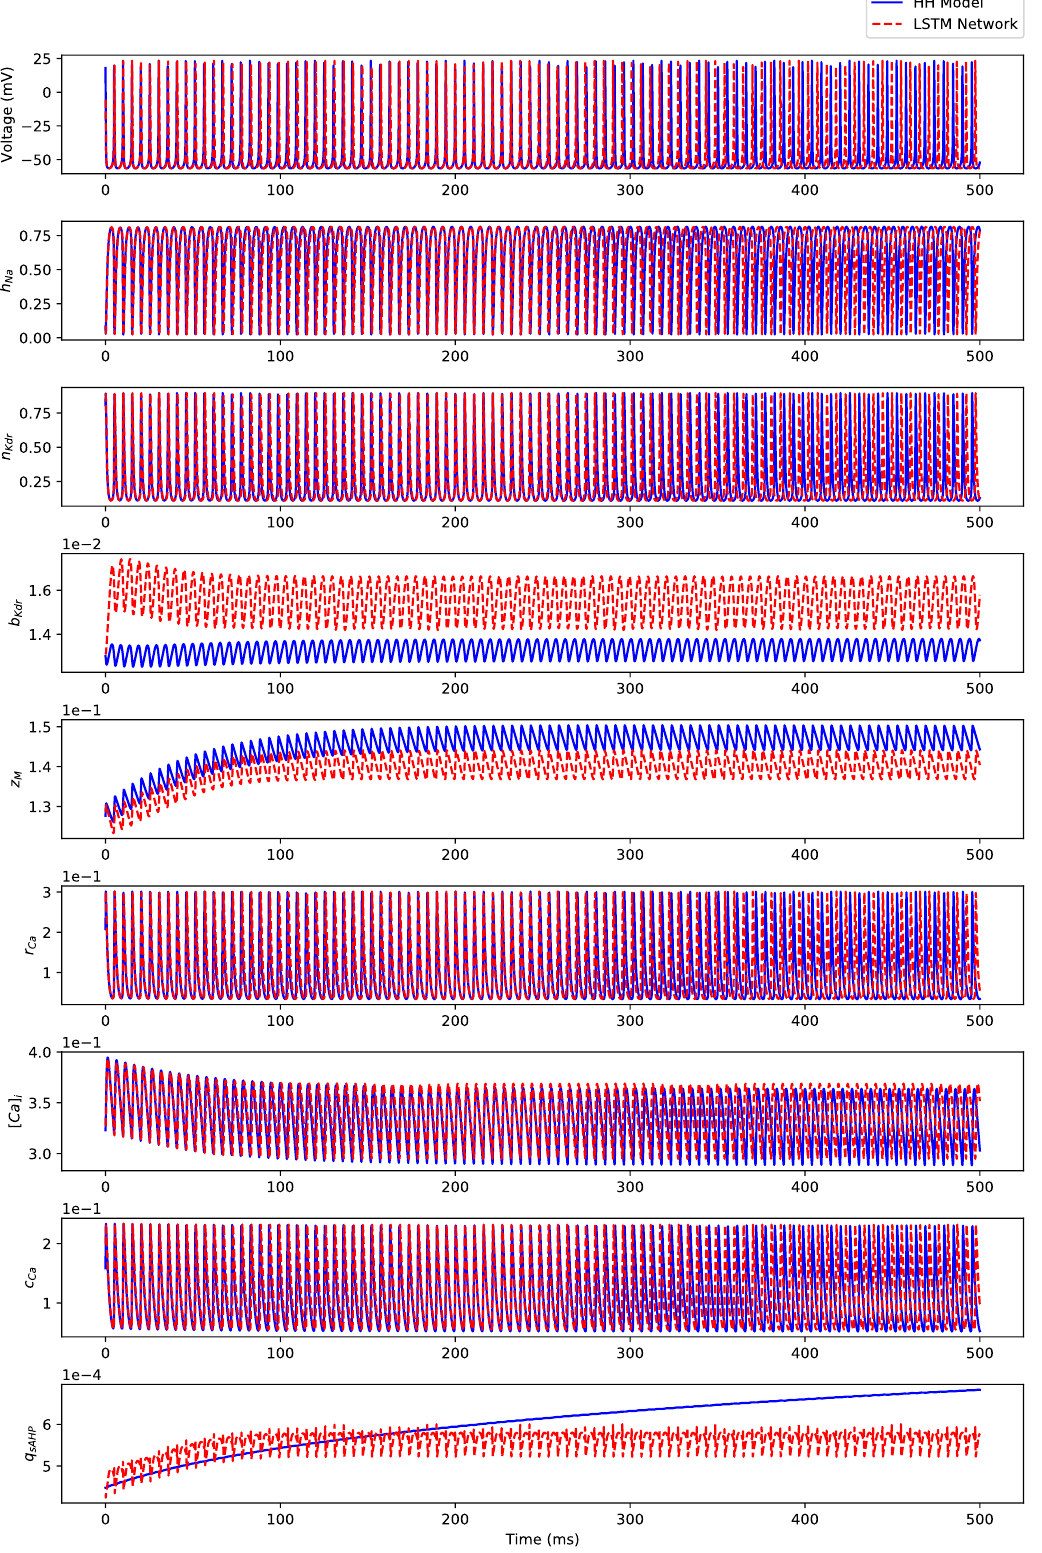
Figure A1. Comparison between the Hodgkin-Huxley model (“HH Model”) states’ dynamics and the iterative predictions of states’ dynamics using the 1 timestep predictive horizon-based deep LSTM neural network (“LSTM Network”) in response to I = 3.0